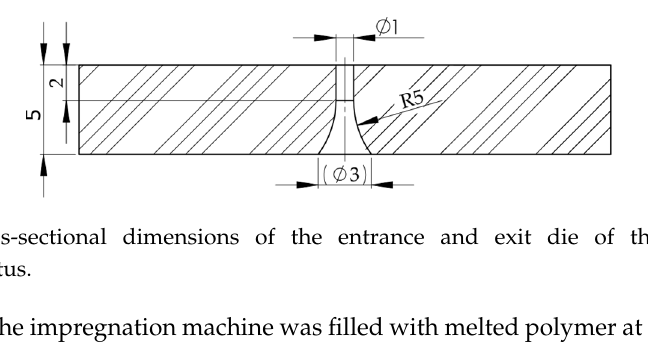
Figure 2. Process chain of shaping by compression of heat-shrinkable tube—shrink tube consolidation (STC): process diagram ( left ) and schematic of manufacturing steps ( right ).